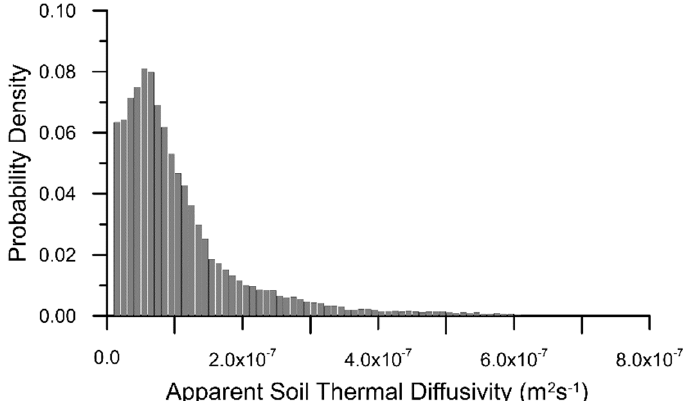
Figure 14. Probability density of Apparent Thermal Soil Diffusivity at TDCs.